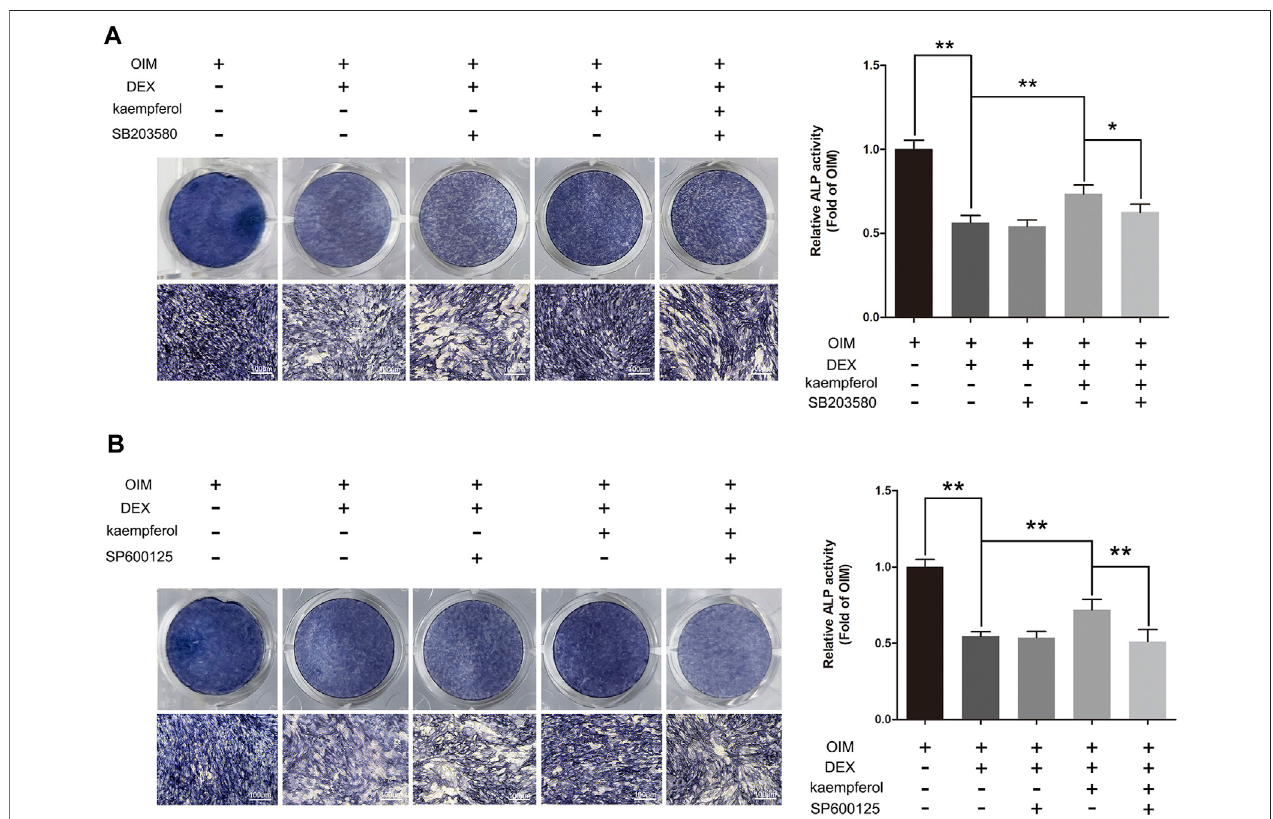
FIGURE 9 | SB203580 and SP600125 inhibited the protective effect of kaempferol in DEX-treated MC3T3-E1 Cells. (A) ALP staining was performed with BCIP/ NBTkit after the MC3T3-E1 cells were treated with SB203580, DEX and kaempferol for 5 days. (B) ALP staining was performed with BCIP/NBT kit after the MC3T3-E1 cells were treated with SP600125, DEX and kaempferol for 5 days. OIM, osteogenic induction medium; DEX, dexamethasone. * p < 0.05, ** p <